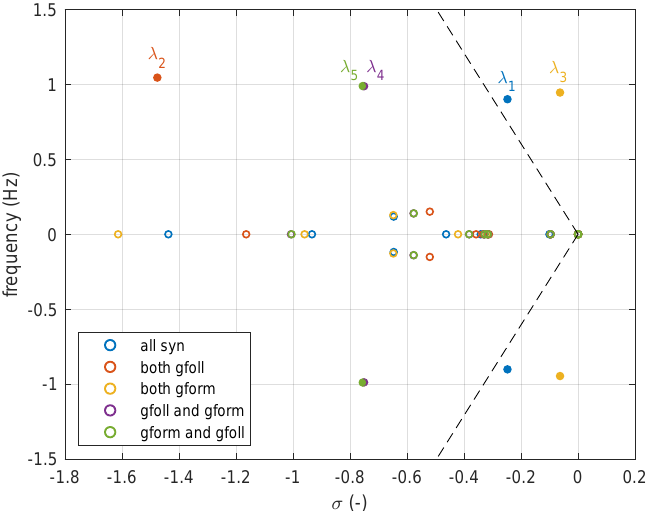
Figure 7. Eigenvalues of the examined cases. Table 2. System modes in the electromechanical oscillations region. Eigenvalue Damping Ratio ζ